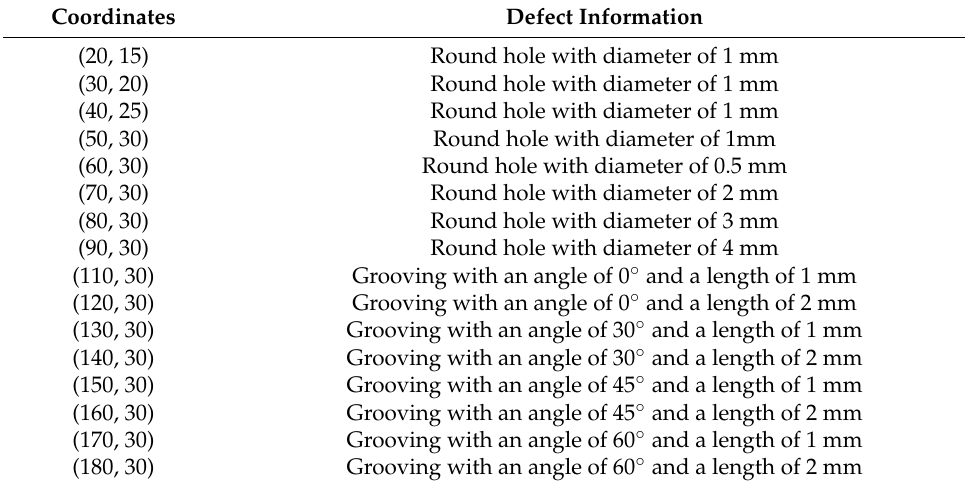
Figure 1. The drawing of artificial defect test block. Table 1. Defect